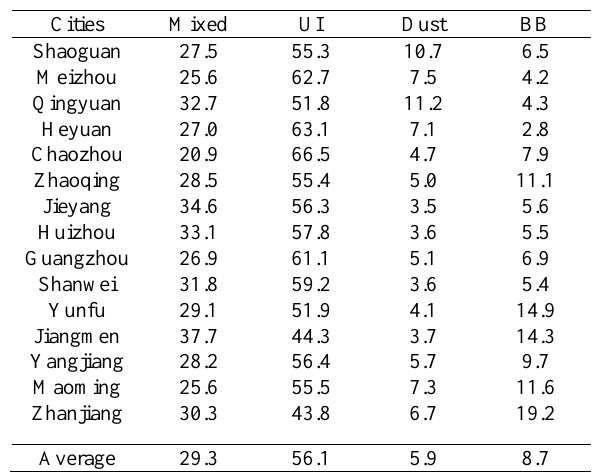
Table 2. The proportion of aerosol types in different cities